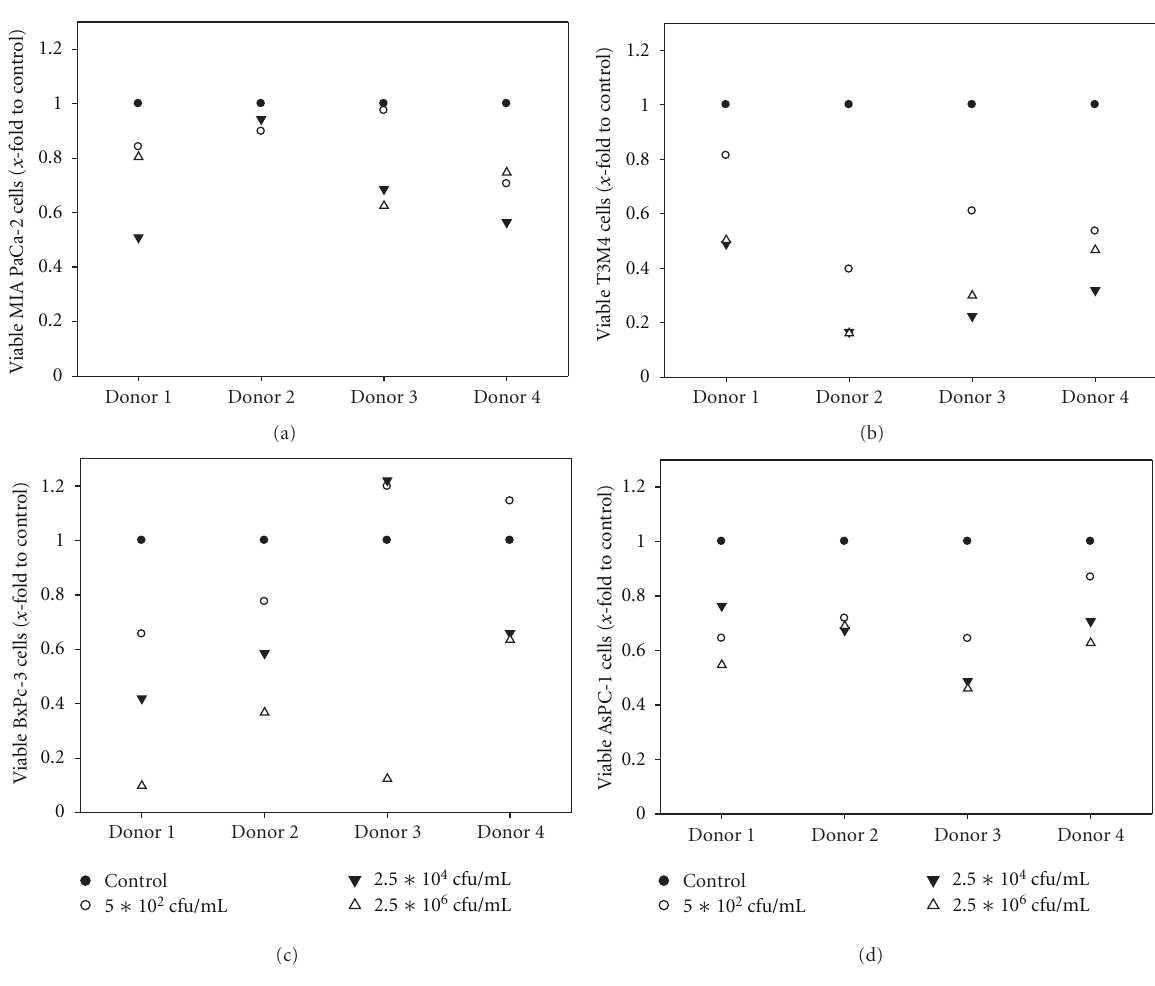
Figure 5: Co-culture experiments. Tumor cells were Co-cultured with huPBLs of four di ff erent healthy donors in the presence of CT for 48hours. Thereafter, numbers of viable tumor cells were quantified by flow cytometry using microsphere beads as calibrator. Untreated cells without CT were set as 1 and all other data were given as x -fold increase. Experiments were performed in duplicates.